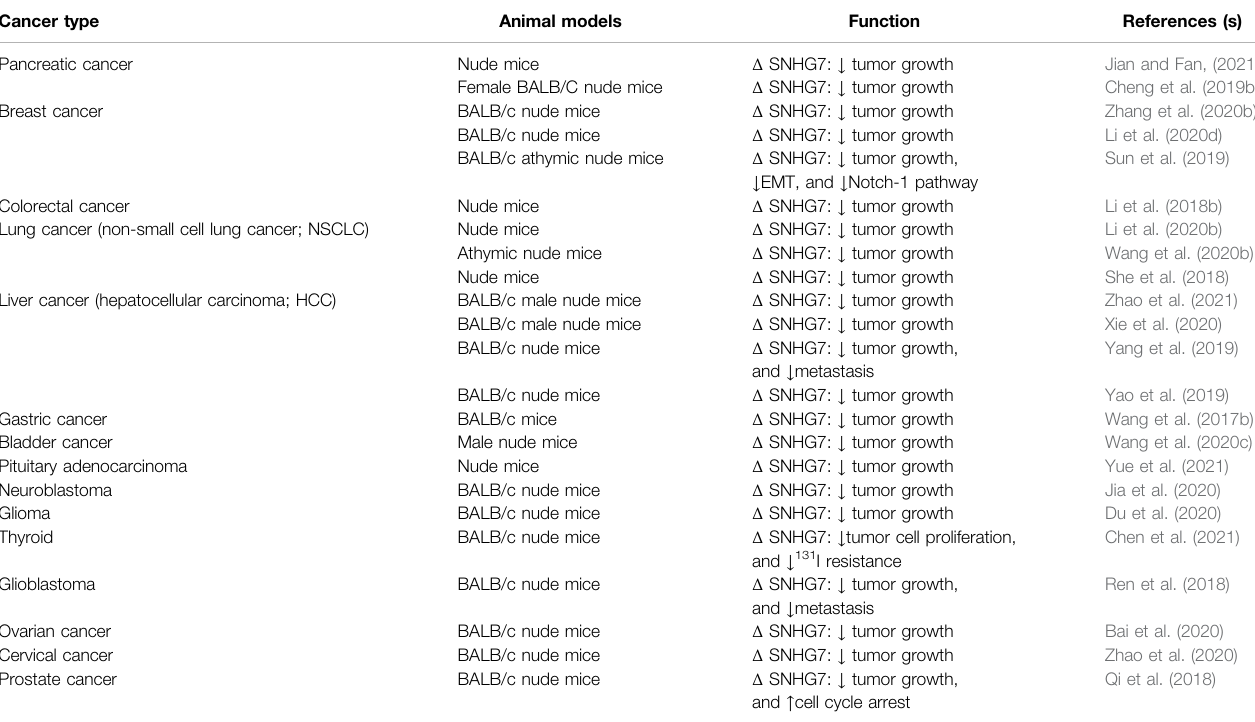
TABLE 1 | Effects of SNHG7 on tumor growth and metastasis in animal studies. Cancer